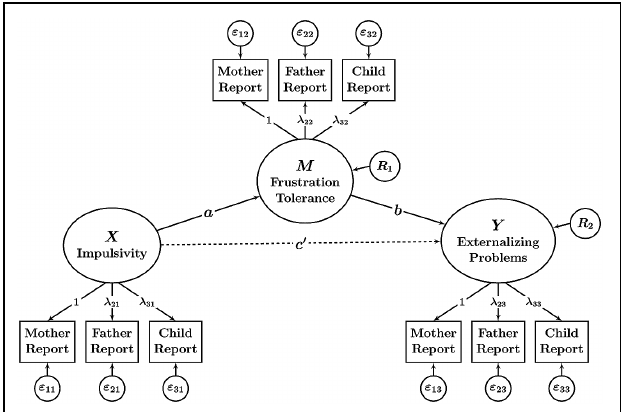
FIGURE 2 | Path diagram illustrating a mediation model with latent variables. In this model, observed variables (different informants’ reports; shown in boxes) serve as indicators of latent variables (shown in ellipses). Statistical mediation is examined between latent variables that are corrected for measurement error and informant-specific effects. The parameters a , b , and c ’ denote path (regression) coefficients. R 1 and R 2 : latent residual variables. The parameters λ mt denote factor loadings ( m = method or type of informant, t = trait). The model includes measurement error variables ε mt to account for random errors of measurement. The model does not include latent variables representing method (informant) effects (method